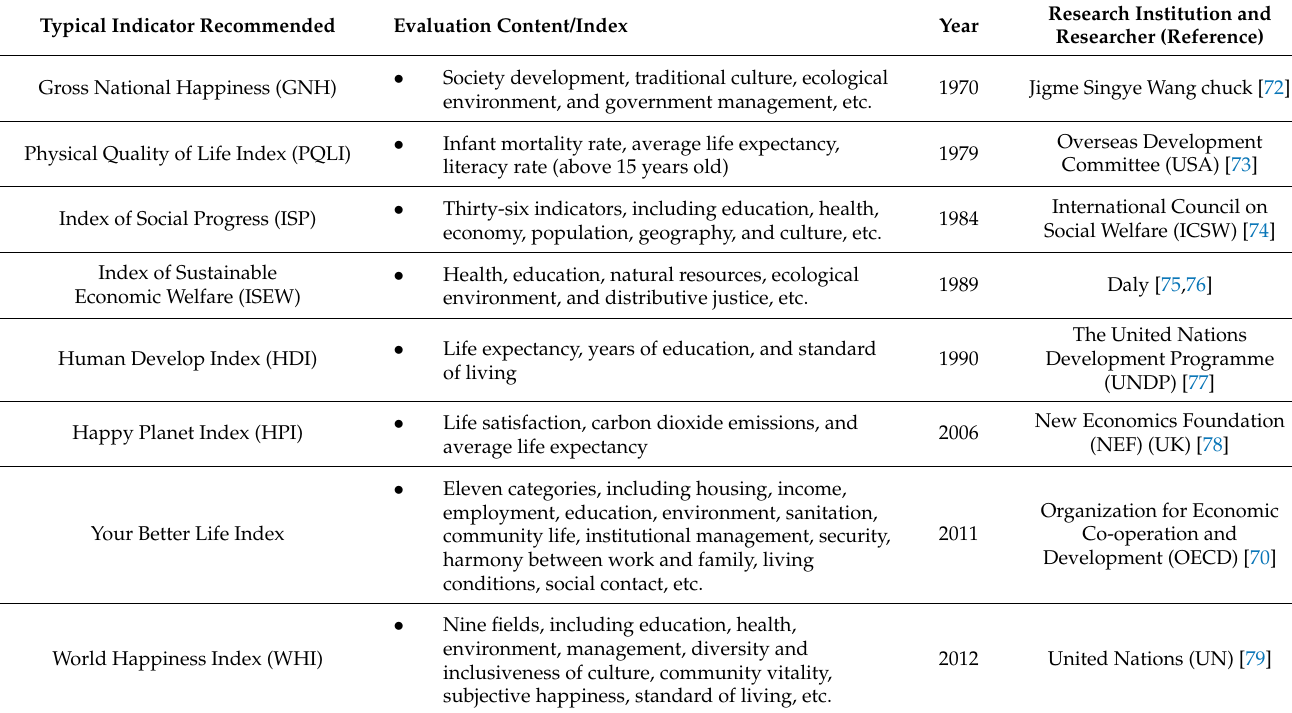
Table 2. Typical indicators for evaluating well-being